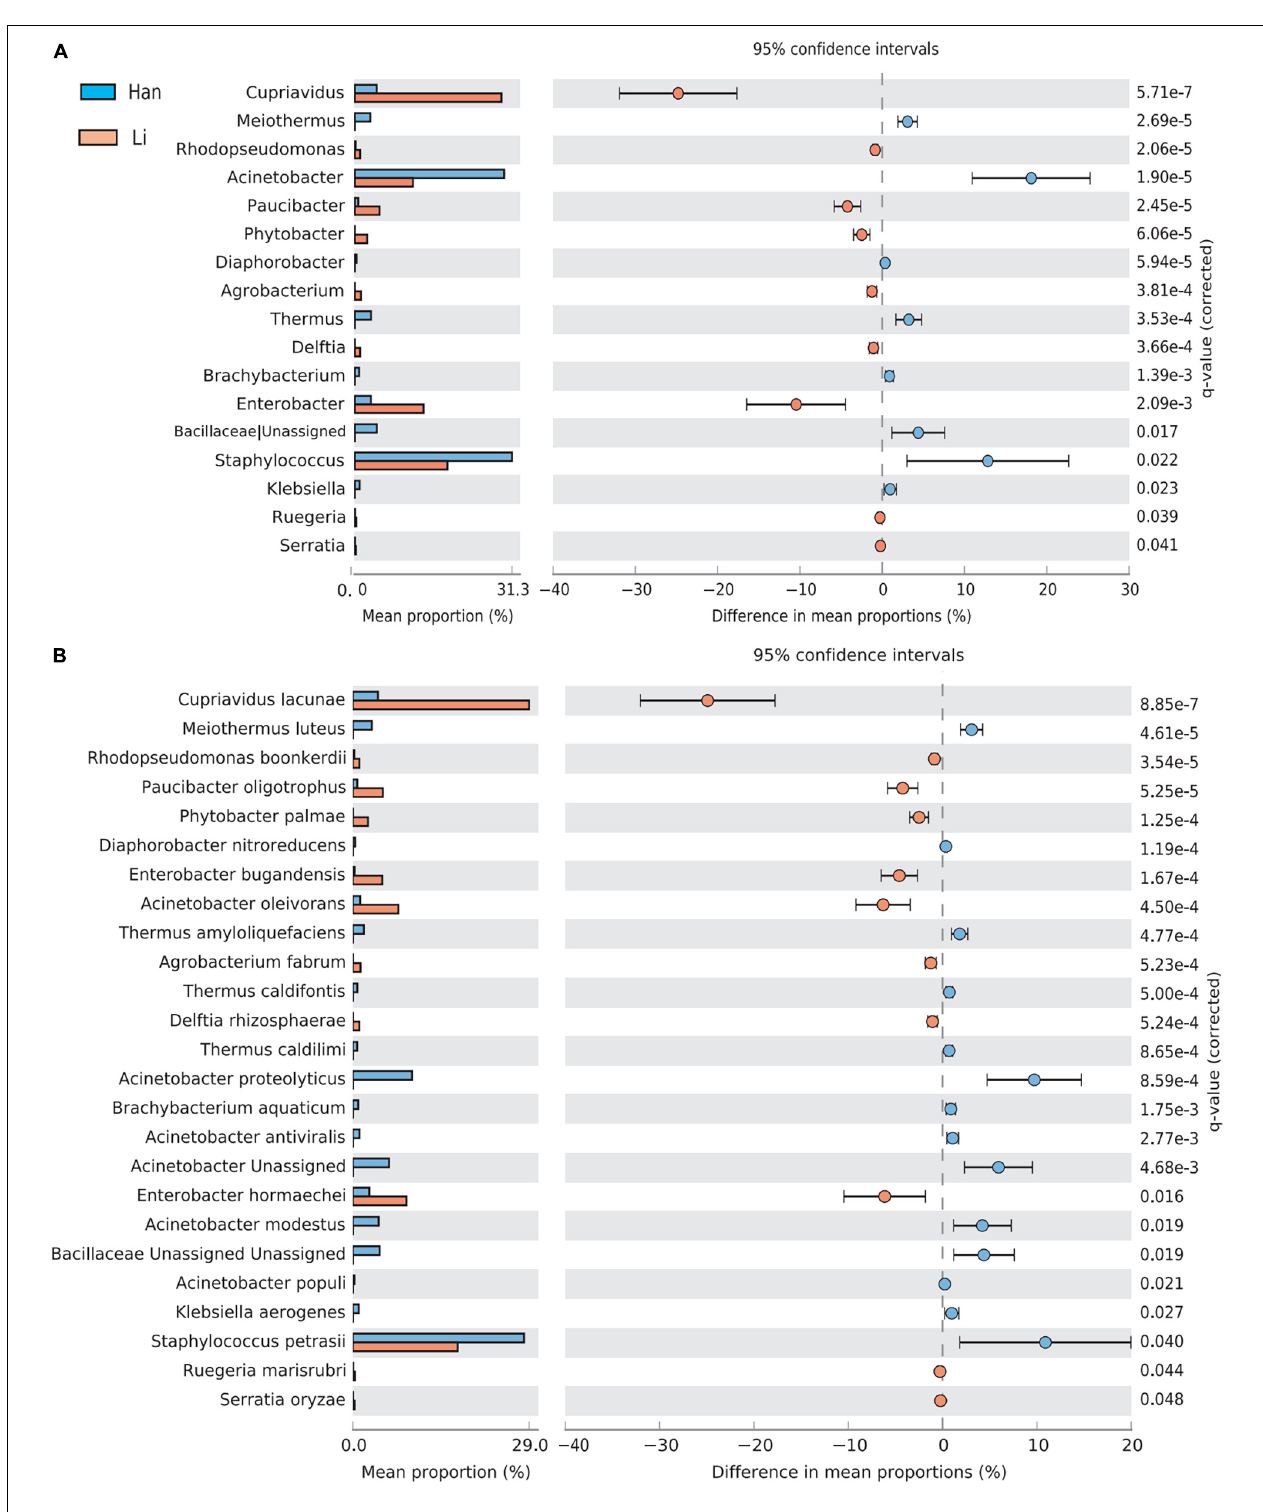
FIGURE 5 | Analysis of the difference of taxa between groups at the genus (A) and species level (B) . Different colors represent different groups. The left figure in the picture shows the abundance ratio of different taxa in the two groups of samples, the middle shows the difference ratio of functional abundance in the 95% confidence interval, and the right value is the p